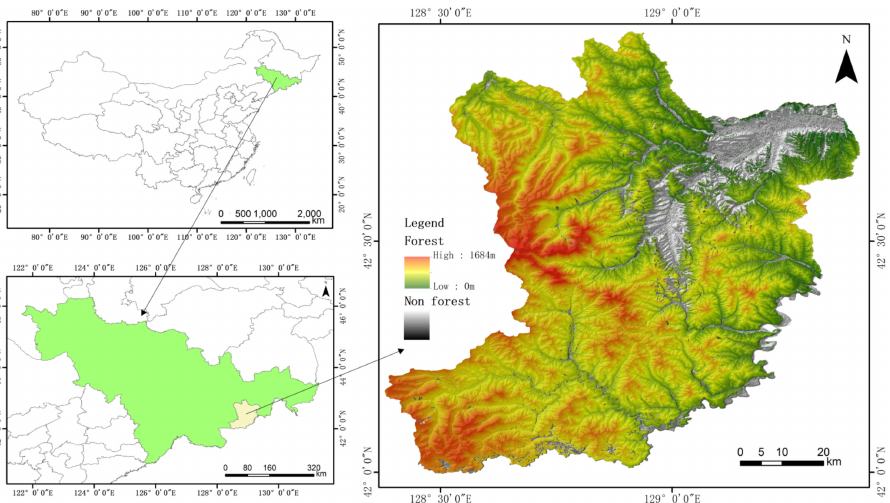
Figure 1. The study area. The forest area is overlaid with Shuttle Radar Topography Mission elevation